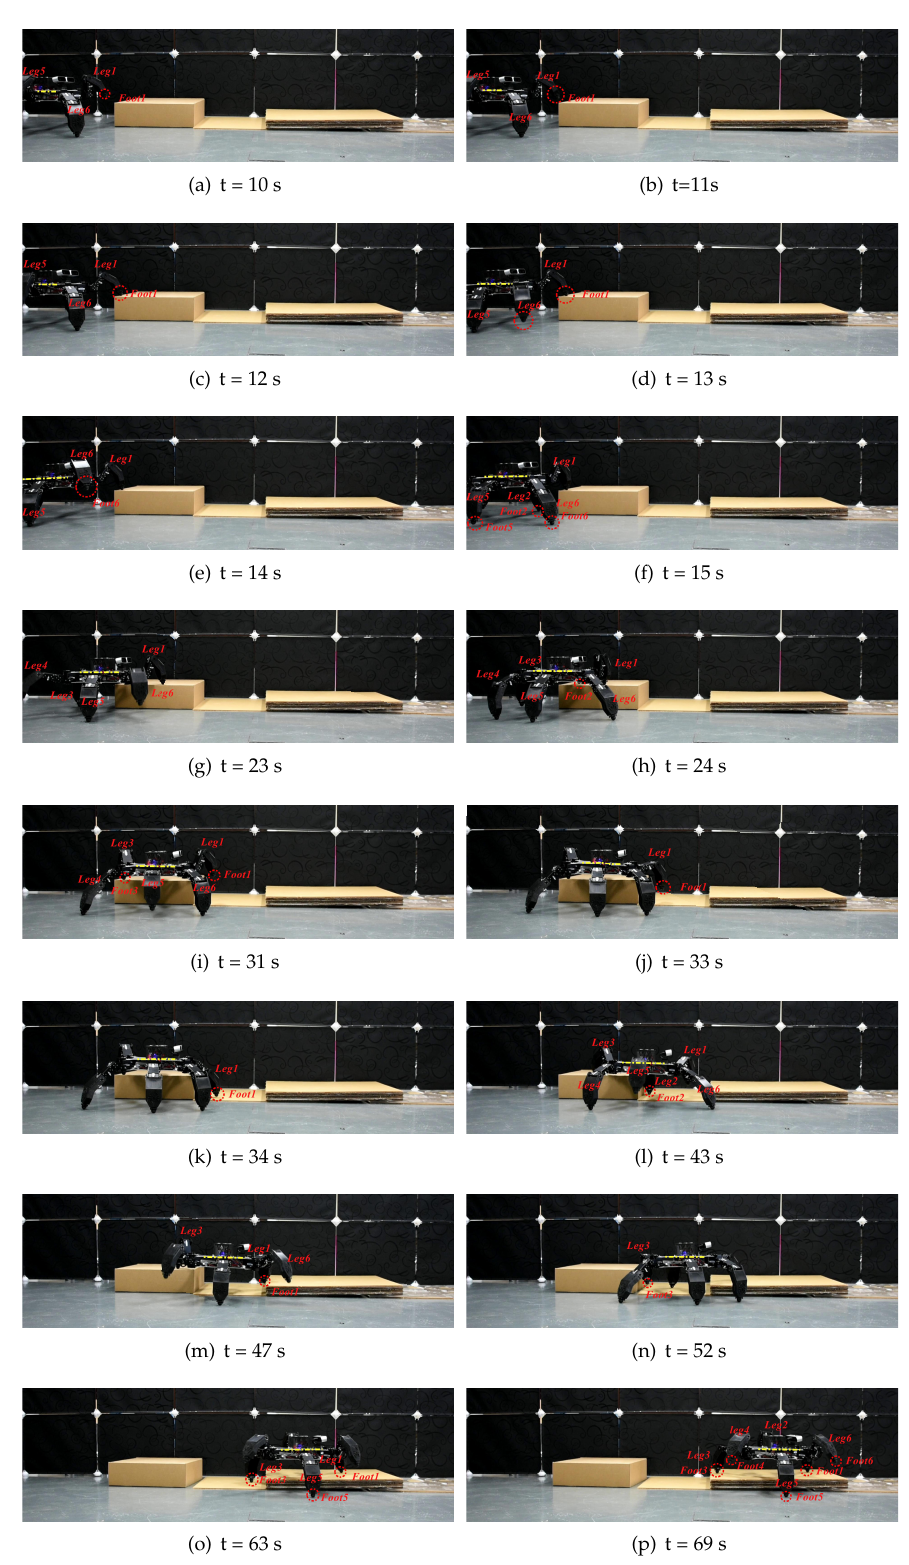
Figure 14. Hexapod robot’s movement with